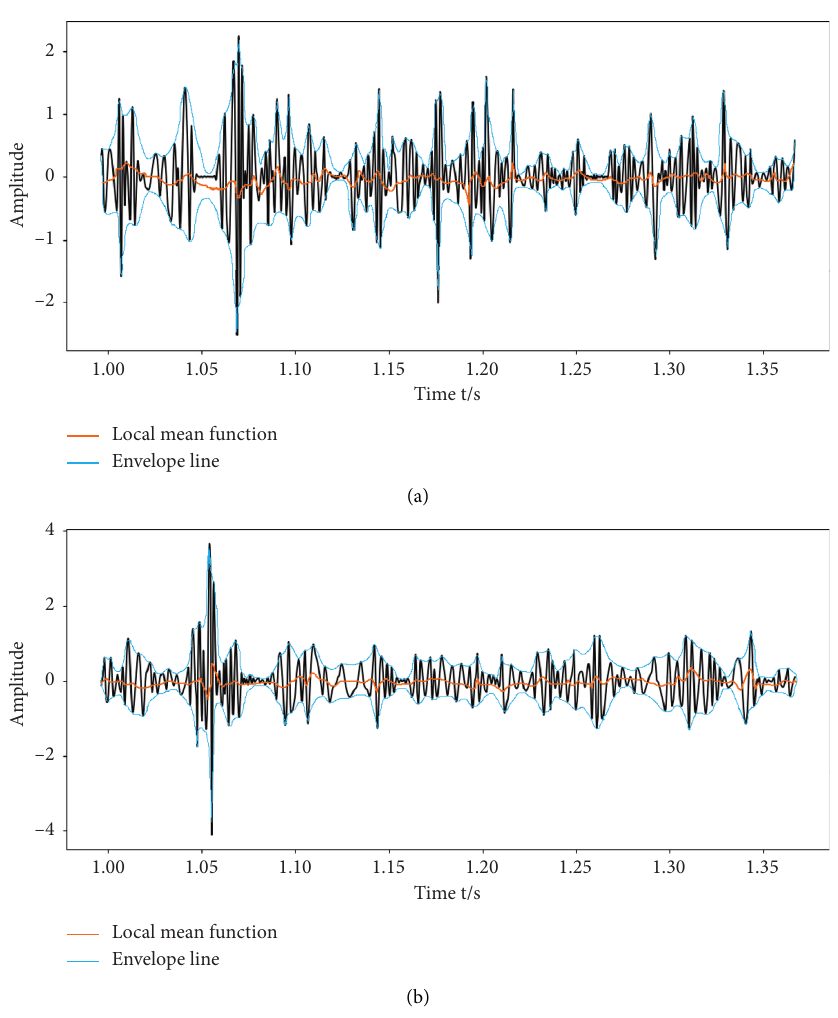
Figure 1: Vibratory signals with two different